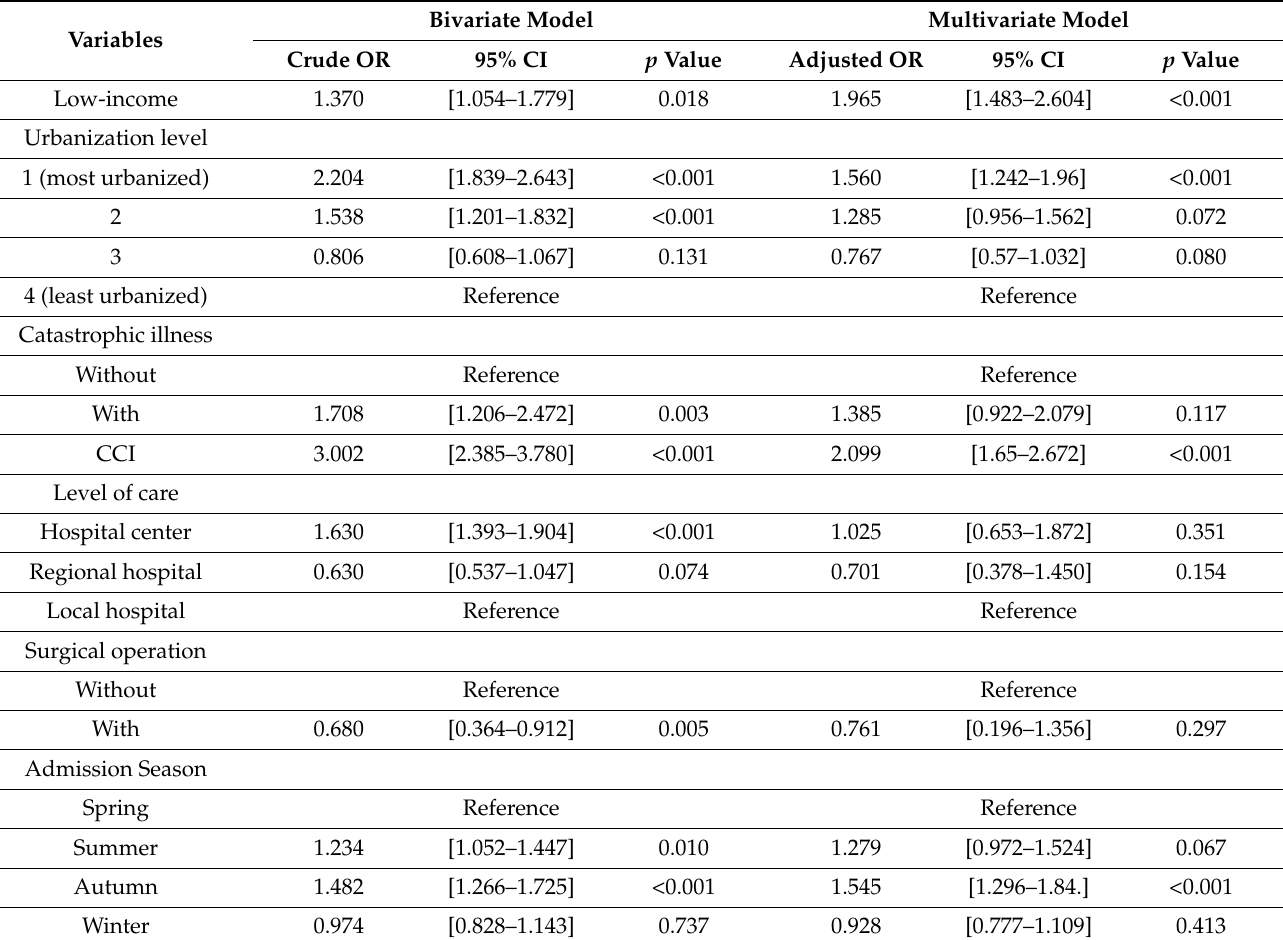
Adjusted OR = Adjusted odds ratio: Adjusted variables listed in the table, CI = confidence